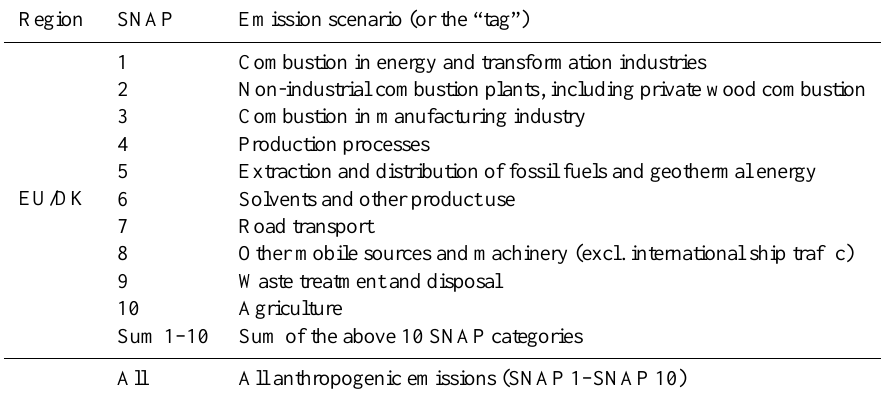
Table 2. Definition of the specific scenarios (or “tags” in the model). Each scenario is defined by a region – either Europe (EU) or Denmark (DK), SNAP category (first column) and a short description of the emissions of interest in the scenario. The scenarios are either run for emissions covering the whole of Europe (DEHM domain 2) or